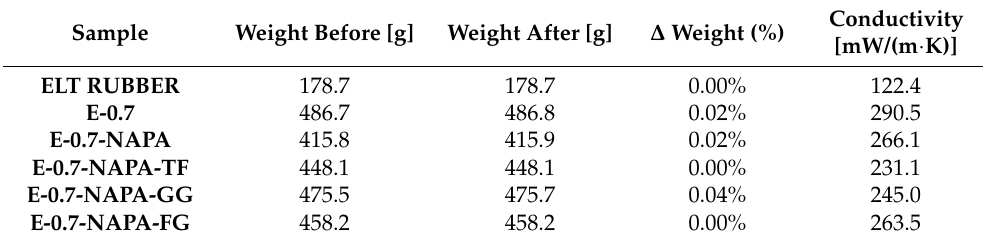
Figure 19. Dispersion comparative thermal conductivity results. Values obtained by those samples with ELT additives are close to each other. As a main advantage, density is lower than reference in all samples, and all of them are behind standard limits. The study performed by Guna et al. used natural wool and coir fibre to develop thermal and moisture resistant ceiling tiles gypsum based [11]. This study rec- orded 840 kg/m 3 samples densities, which is a low density. However, results are like the reference, and all of them are above those with ELT additive. The best value achieved is 260 mW/(m·K), and only E-0.7-NAPA performed worse. Ouakarrouch et al. developed a new light plaster by adding animal feathers. In this case, values obtained were worse than all compared values [50].